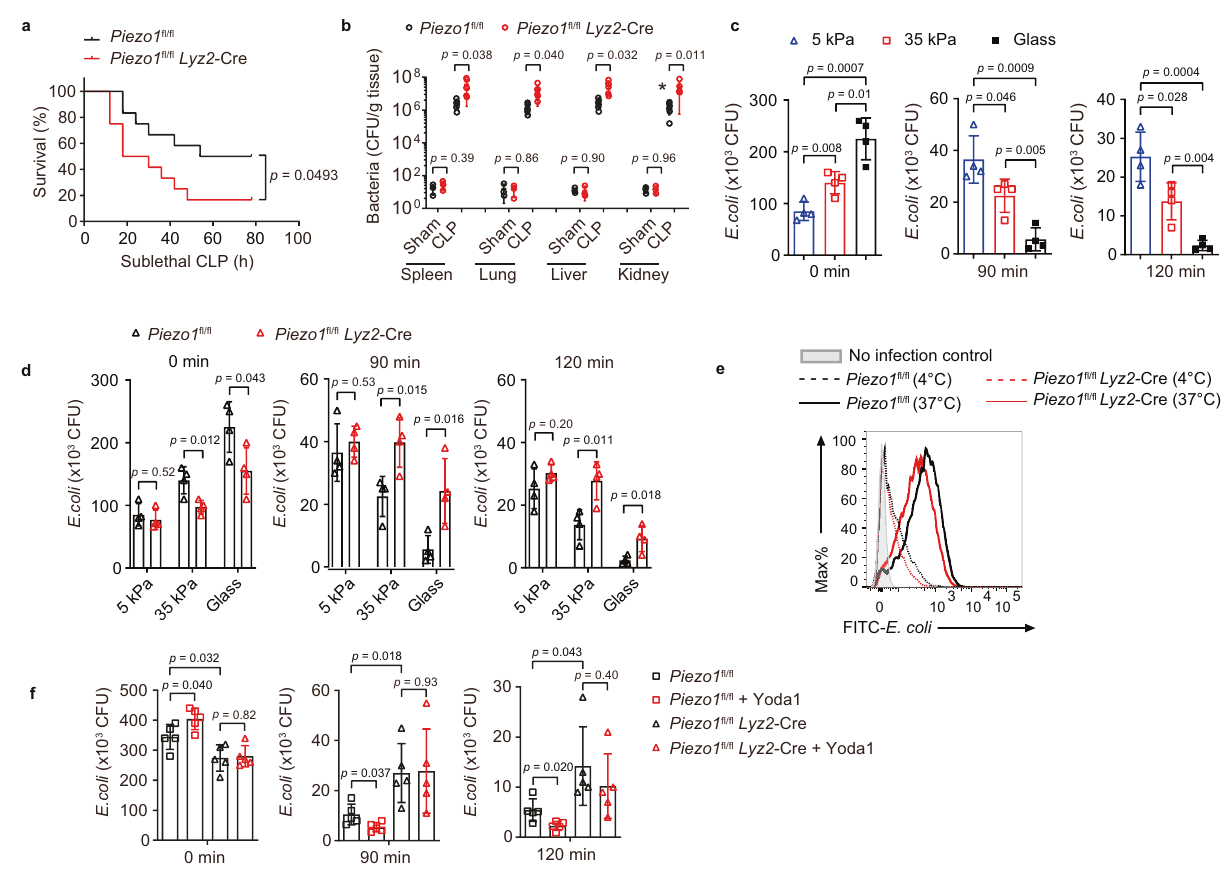
Fig. 2 Piezo1 de fi ciency impairs phagocytosis and bactericide of macrophage. a , b Piezo1 fl / fl or Piezo1 fl / fl Lyz2 -Cre mice ( n = 12 mice per group per experiment) subjected to sublethal CLP. The p -value of mortality Mantel – Cox test is indicated ( a ), and the bacterial loads (colony forming units, CFU) measured in the lung, liver, spleen, and kidney after CLP induction (Sham group n = 3, CLP group n = 6) ( b ). c , d Pathogen burden (CFU) in wild-type ( c , d ) or Piezo1-de fi cient ( d ) BMDMs infected with E. coli (MOI, 20) for 0, 90, or 120 min on different stiffness culture matrix, 5 kPa, 35 kPa, or glass ( n = 4 independent samples). e Flow cytometry of Piezo1 fl / fl or Piezo1 fl / fl Lyz2 -Cre BMDMs left uninfected or infected for 20 min at 37 or 4 °C with FITC-labeled E. coli (FITC- E. coli ) at a MOI of 20. f Pathogen burden in Piezo1 fl / fl and Piezo1 fl / fl Lyz2 -Cre BMDMs treated with or without Yoda1 (5 μ M, 30 min), followed by E. coli infection (MOI, 20) for 0, 90, or 120 min ( n = 5 independent samples). Data are presented as mean + / − SD and the p -values of two-tailed unpaired Student ’ s t test are indicated in ( b ), ( c ), ( d ), and ( f ). Data are from one experiment representative of three independent experiments with similar results. Source data are provided as a Source data fi